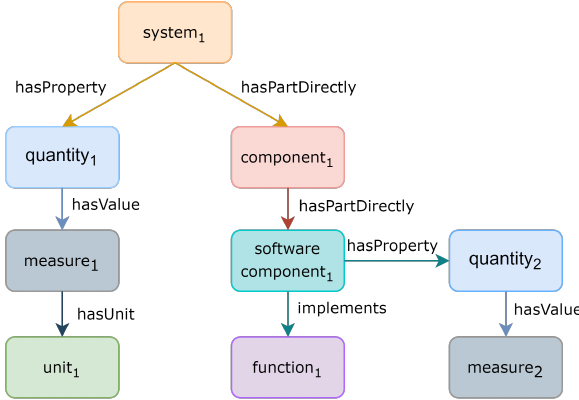
Figure 7. The final output with a sample context of ten sentences.